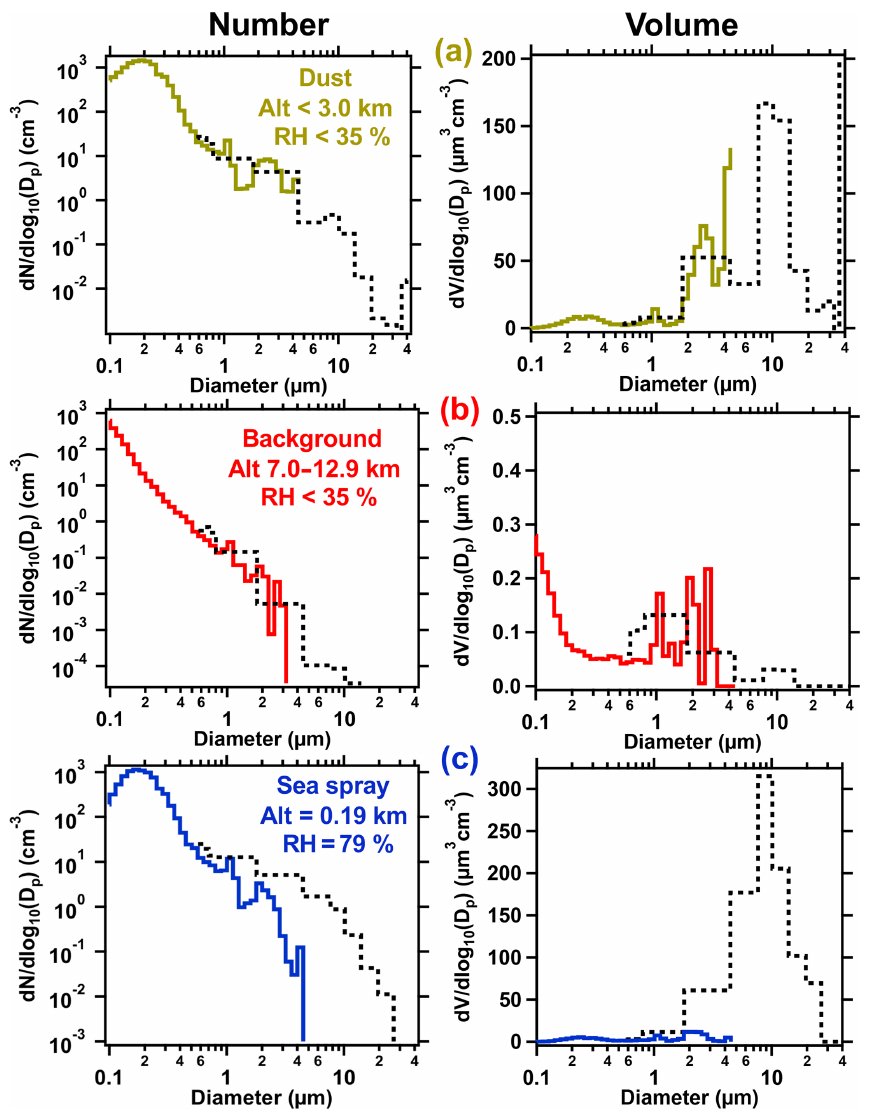
Figure 9. (a) Number size distributions shown on a logarithmic scale (left column) and volume size distributions on a linear scale (right column) from measurements in a Saharan dust plume over the Atlantic Ocean (26 ◦ N, 20 ◦ W) on 16 August 2016 at aircraft altitude <3km and RH liquid <35%. Dry size distributions from the in-cabin instruments are shown with solid lines; near-ambient size distributions from the underwing CAPS probe are shown as dashed lines. (b) As for (a) , but measured at altitudes between 7 and 12.9km when RH liquid was <35%. (c) As (a) , but measured for 5min at 190m in the MBL at 2 ◦ S, 17 ◦ W at RH liquid = 79%. Hydrated sea-spray particles comprise the coarse mode, for which >80% of the particle volume is